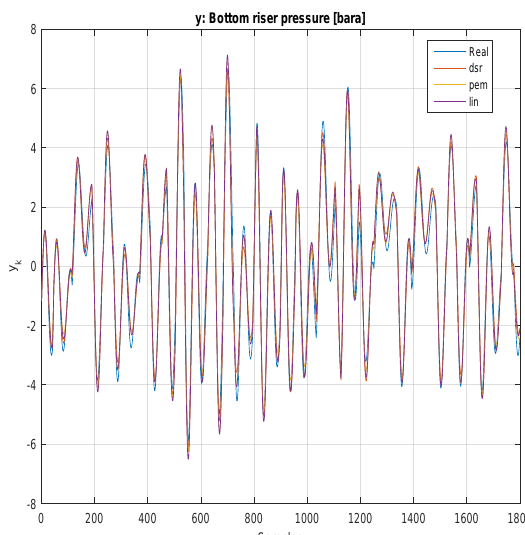
Figure 3: Identification data, N id = 1301 samples. Sampling time is 100 sec. @0.15